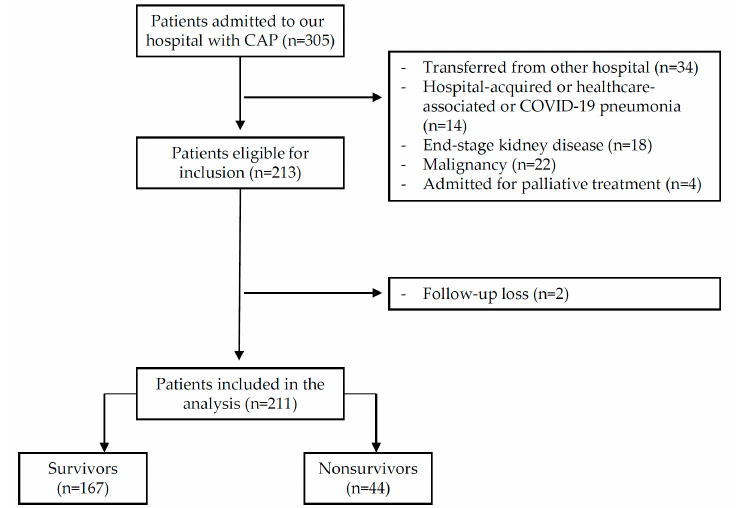
Figure 1. The study flow chart.